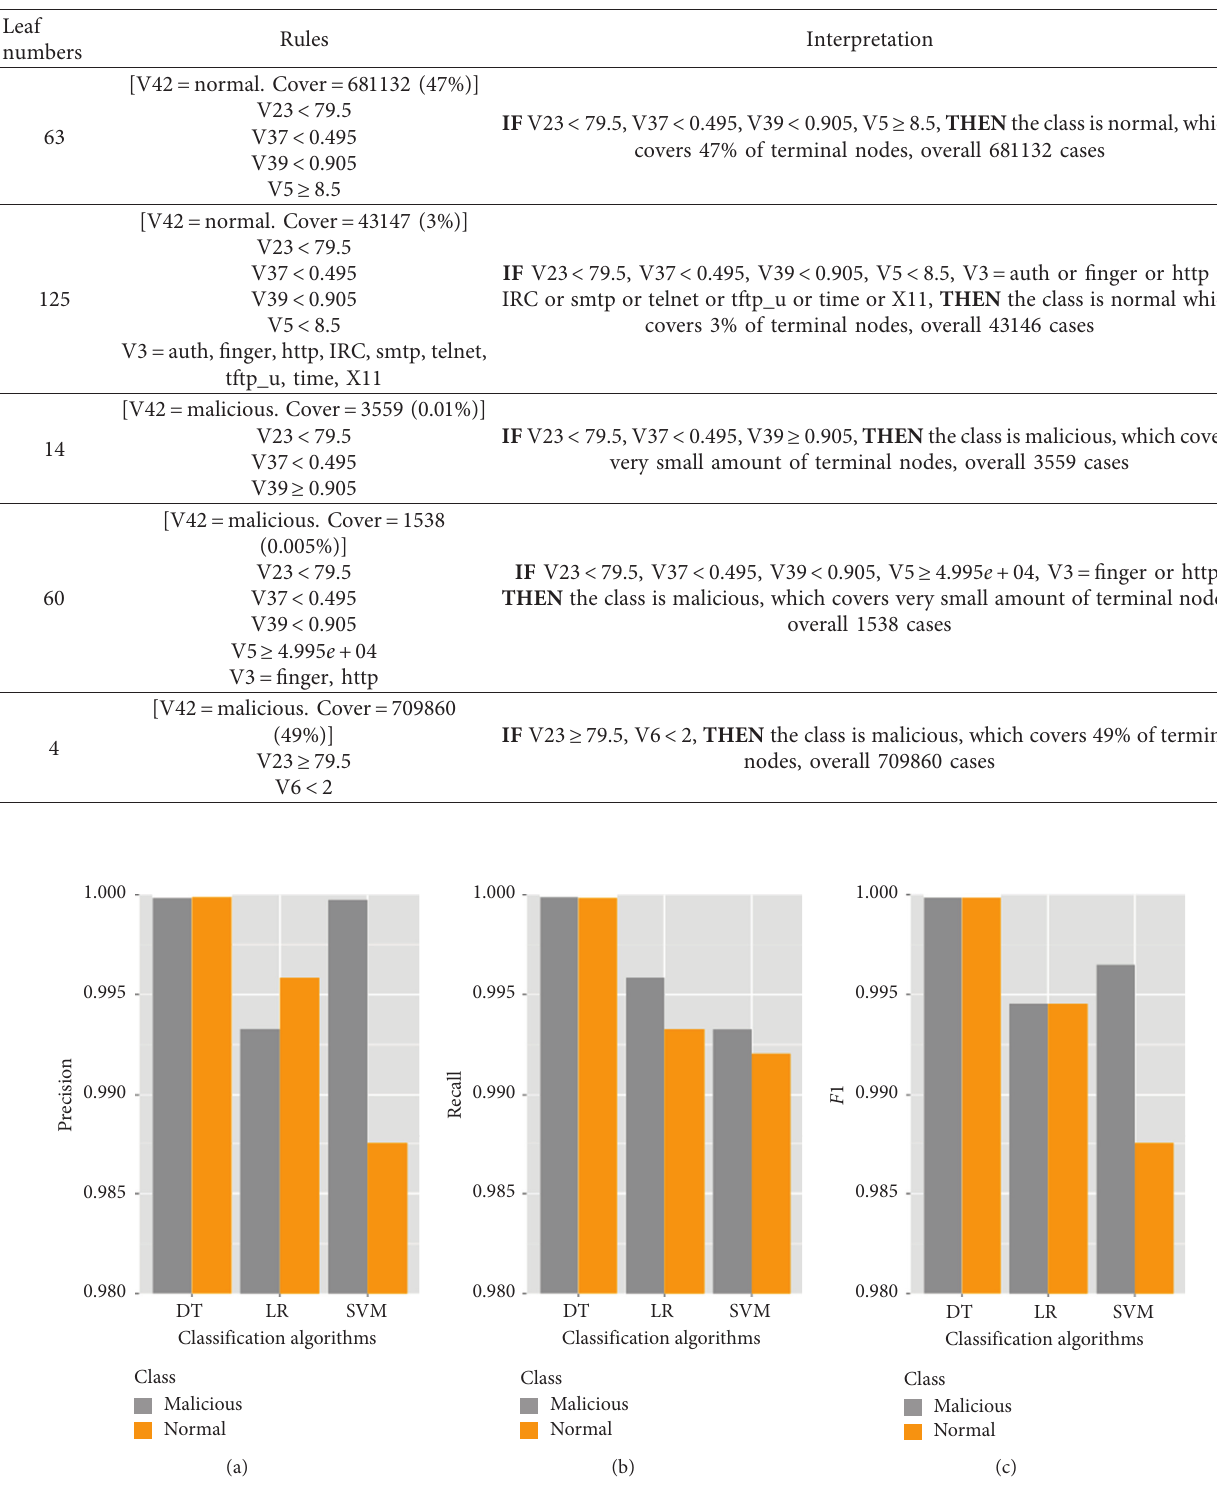
Figure 4: Performance of the state-of-the-art methods in predicting the classes between malicious and normal nodes. LR: logistic regression, DT: decision tree; SVM: support vector machines. (a) Precision. (b) Recall, (c) F